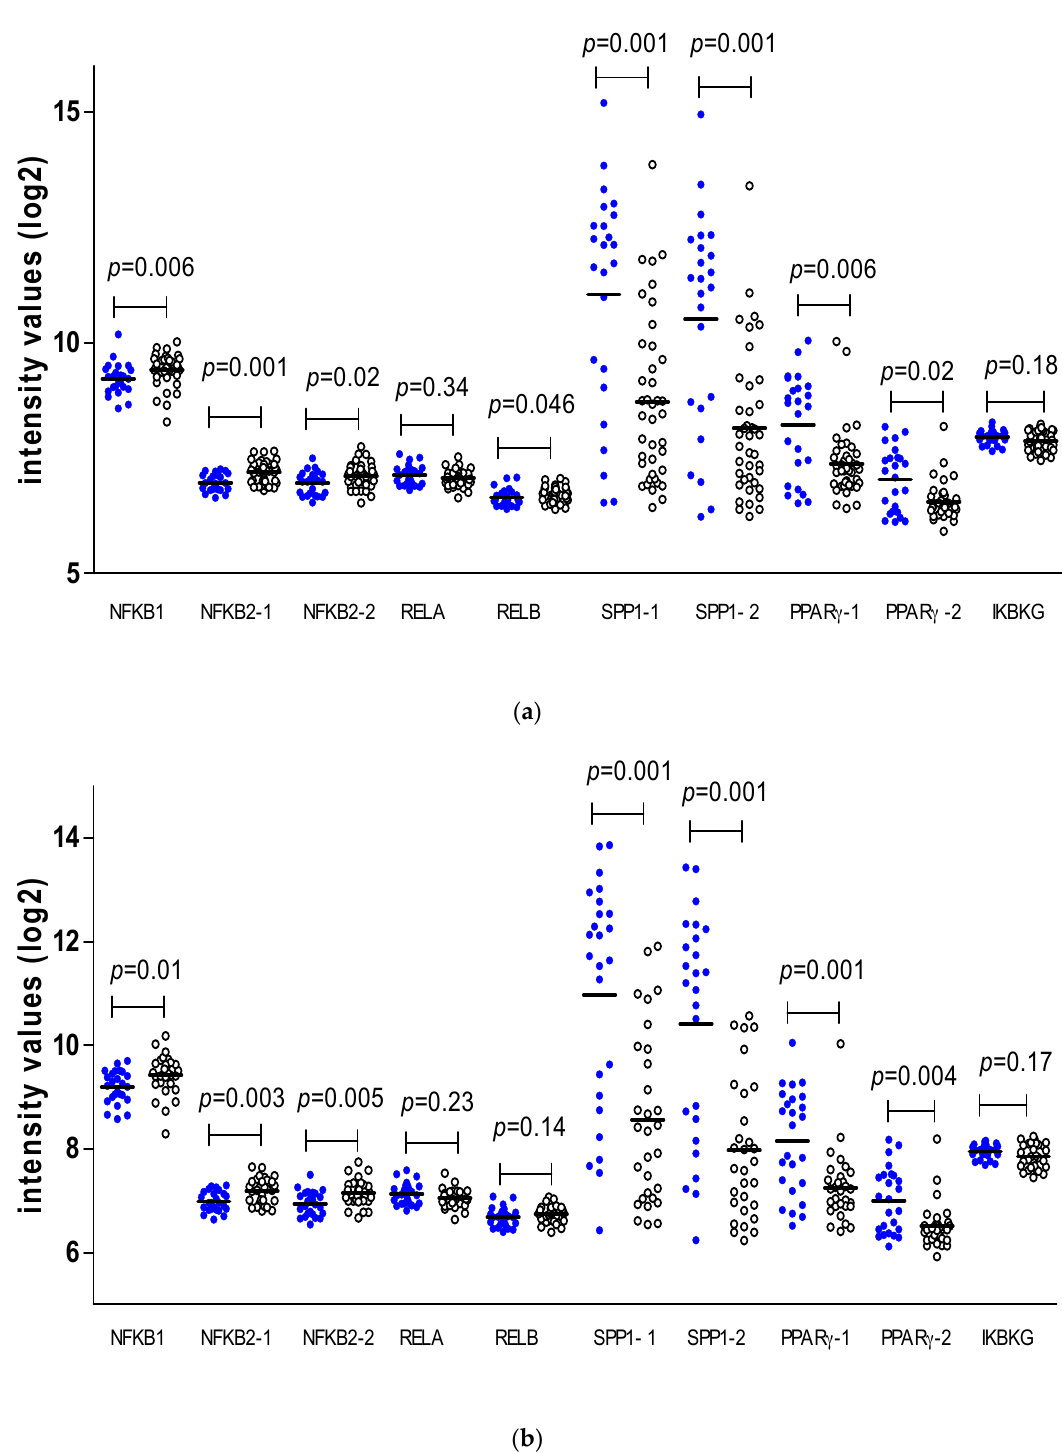
Figure 3. Comparison of expression of factors involved in NFkB signalling pathways in ( a ) D3 ( ● blue) ( n = 24) versus M3 (o white) ( n = 40), and ( b ) BAP1-positive ( ● blue) ( n = 25) versus BAP1-negative (o white) ( n = 30) tumors. Mann–Whitney U test, p ≤ 0.05 is considered significant. Thick bars indicate the means.